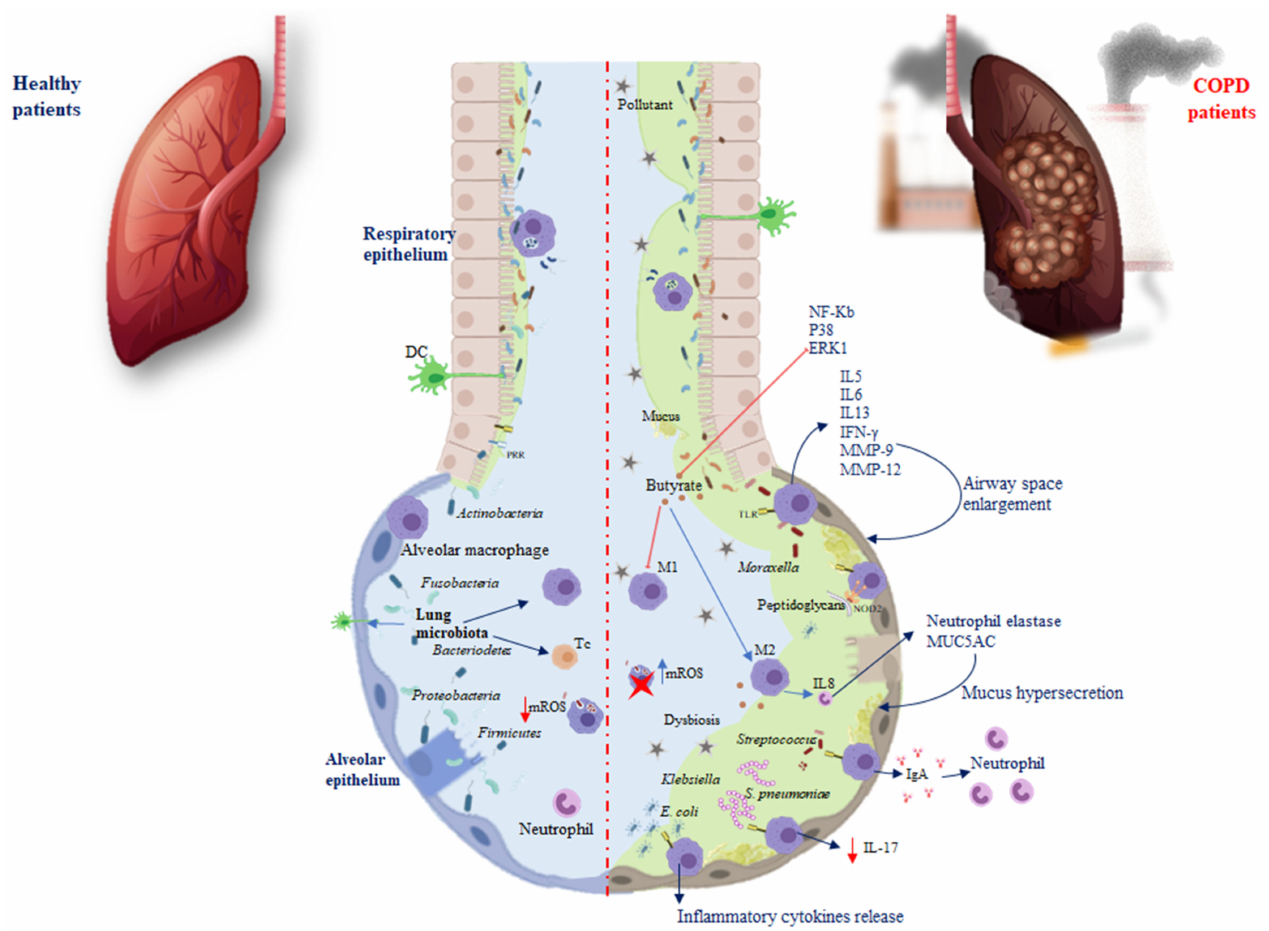
Figure 1. Differences in microbiota immunoregulation in the alveolar epithelium of healthy in- dividuals and COPD. Red arrows show inhibition processes, while blue arrows show activation processes. Abbreviations: pattern recognition receptors (PRRs); Toll-like receptors (TLRs); Treg cells (Tc); macrophages (M); DCs (dendritic cells); Immunoglobulin A (IgA); Interleukin (IL); interferon- gamma (IFN- γ ); matrix metalloproteinase (MMP); mitochondrial reactive oxygen species (mROS); nuclear factor kappa-light-chain enhancer (NF-Kb); P38 mitogen-activated protein kinases (P38); extracellular signal-regulated kinase (ERK1). Red arrow shows an inhibition process; red cross indicates an inactivated